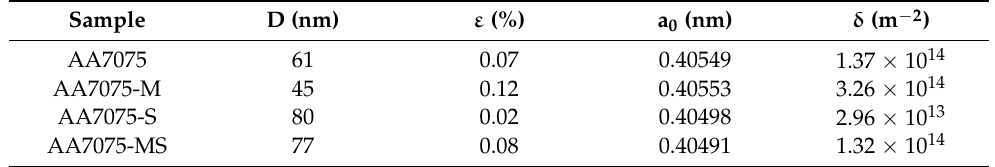
Table 2. Crystallite size D (nm), micro-strain ε (%), lattice parameter a 0 (nm) and dislocation density δ (m − 2 ) powders and dense samples as deduced from the XRD